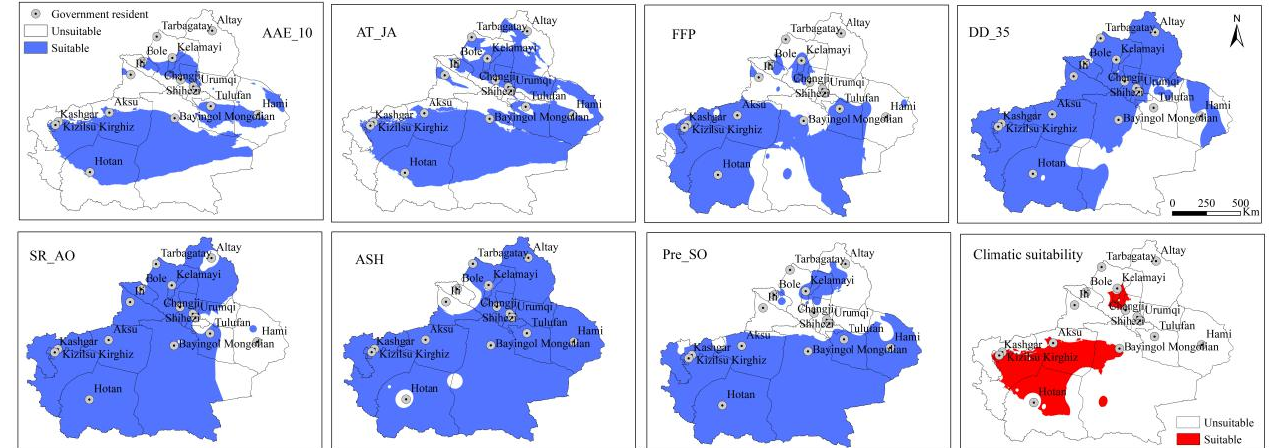
Figure 4. Suitable climate area for early-maturing cotton seed production, AAE_10, the active accumulated temperature equal to or greater than 10 °C; AT_JA, the average temperature in July and August; FFP, the frost-free period; DD_35, the duration in days of temperature equal to or greater than 35 ℃ ; SR_AO, the sunshine rate from April to October; ASH, annual sunshine hours; Pre_SO, precipitation from September to October.